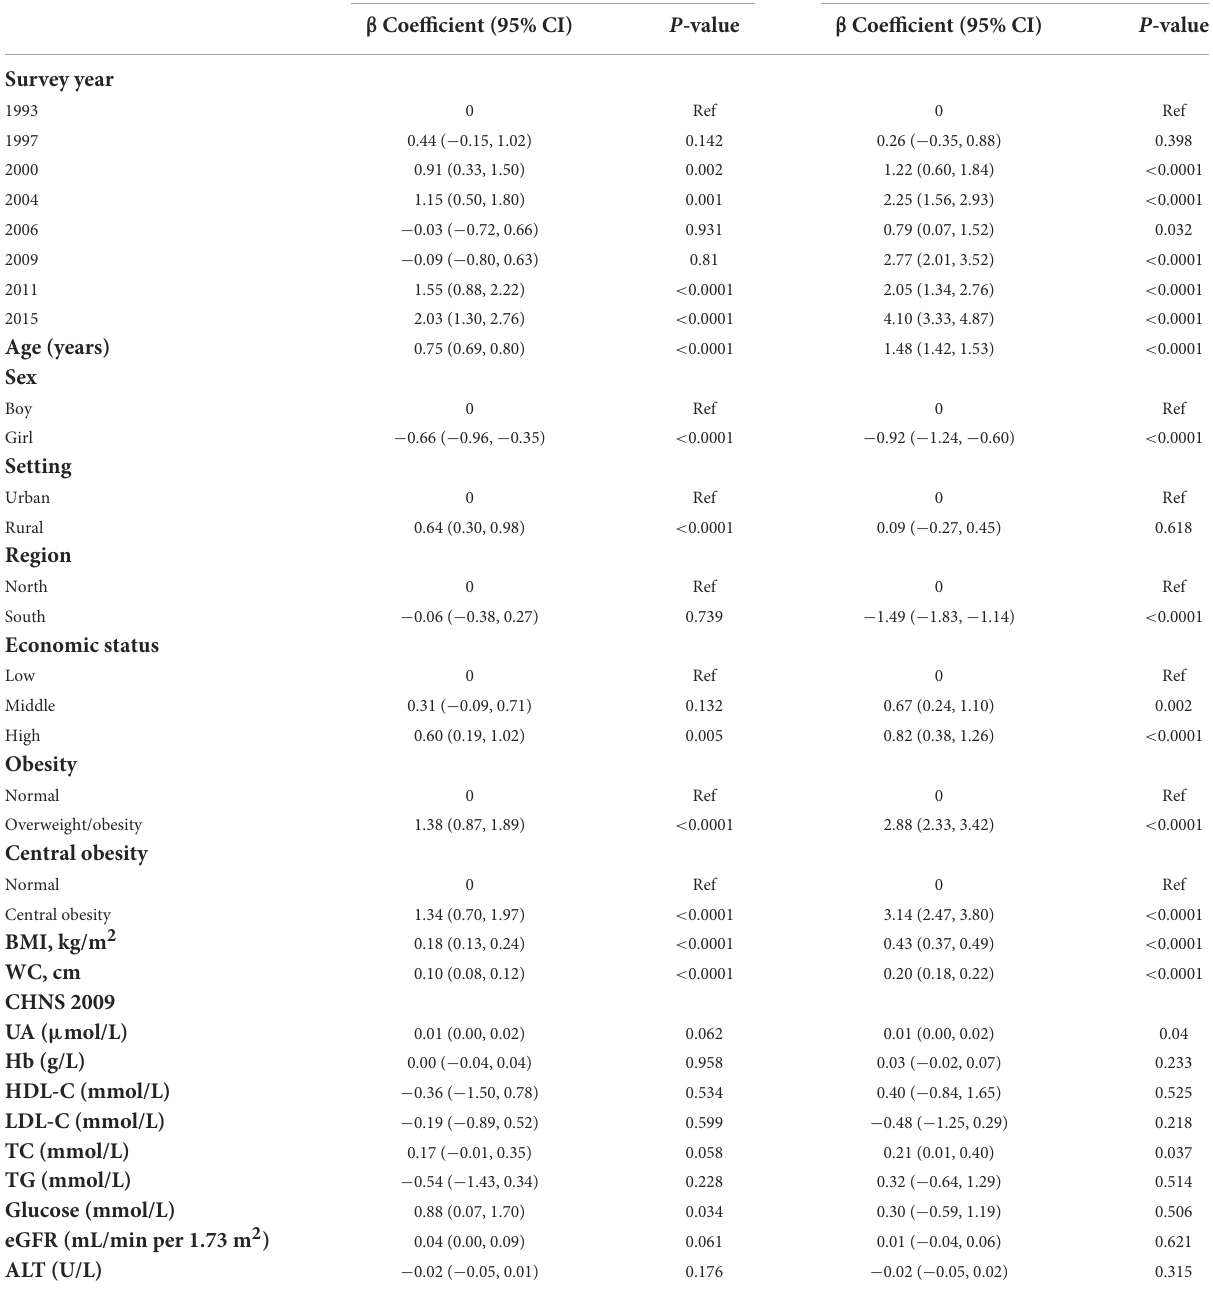
TABLE 3 The associations of demographic, geographic, and anthropometric factors and cardiometabolic factors with PP and MAP. PP MAP β Coefficient (95%